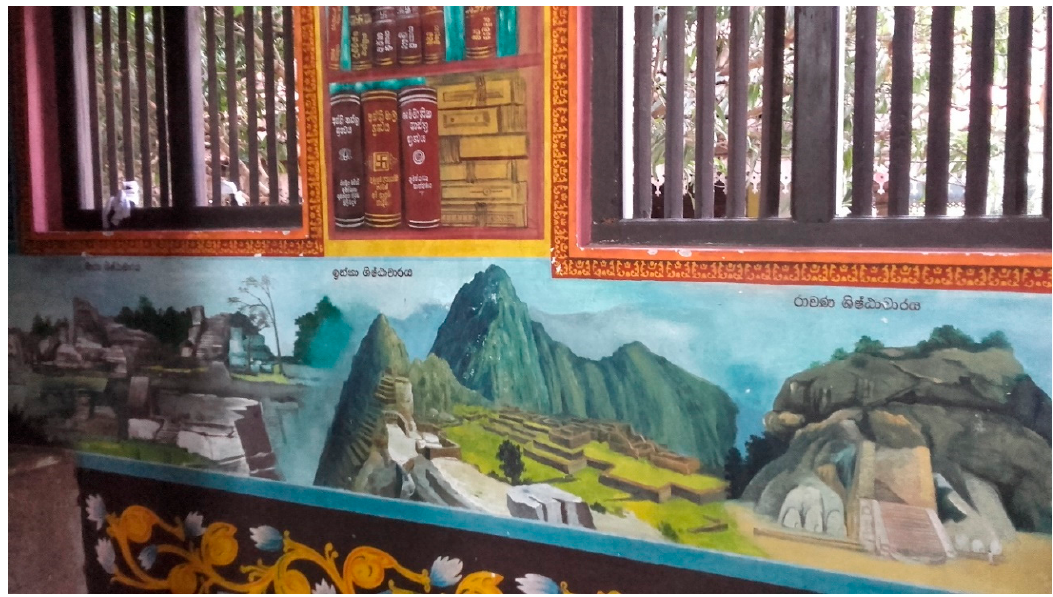
Figure 2. Wall painting in the Ravana mandiraya. This painting shows (from left to right) depictions of the Maya, Inca, and Ravana civilization. The latter is represented by a depiction of the famous Sigirya rock. The painting between the two windows depicts books on medicine. Picture taken by author, 6 June 2017.